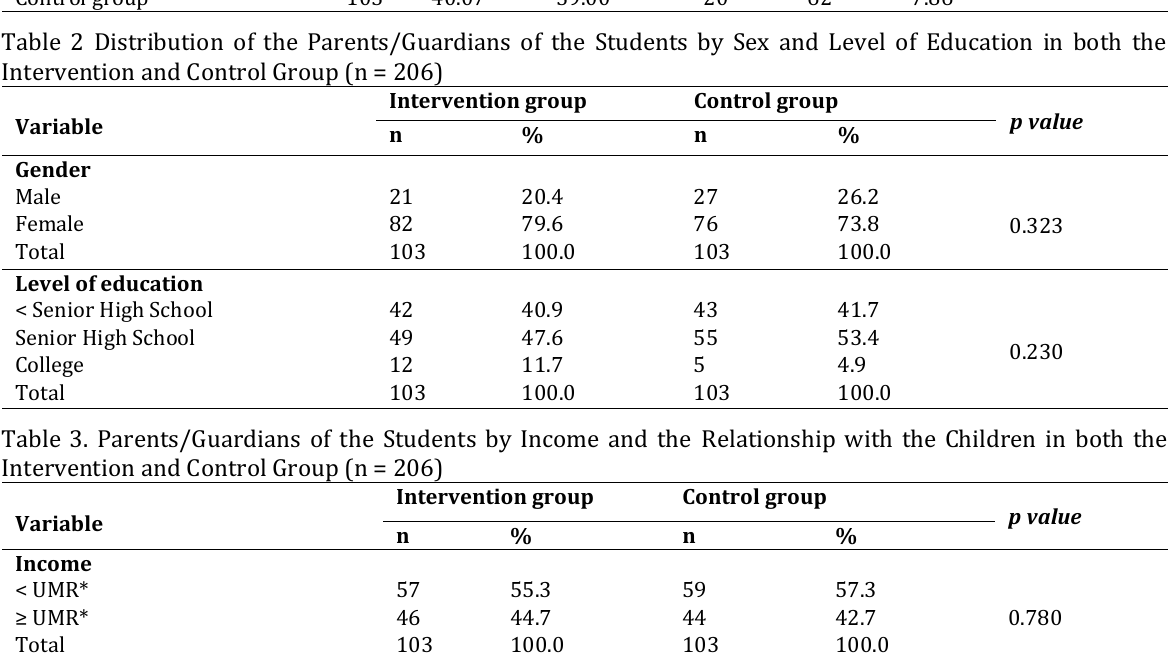
Table 1. Distribution of the Parents/Guardians of the Students by Age in both the Intervention and Control Group (n = 206)